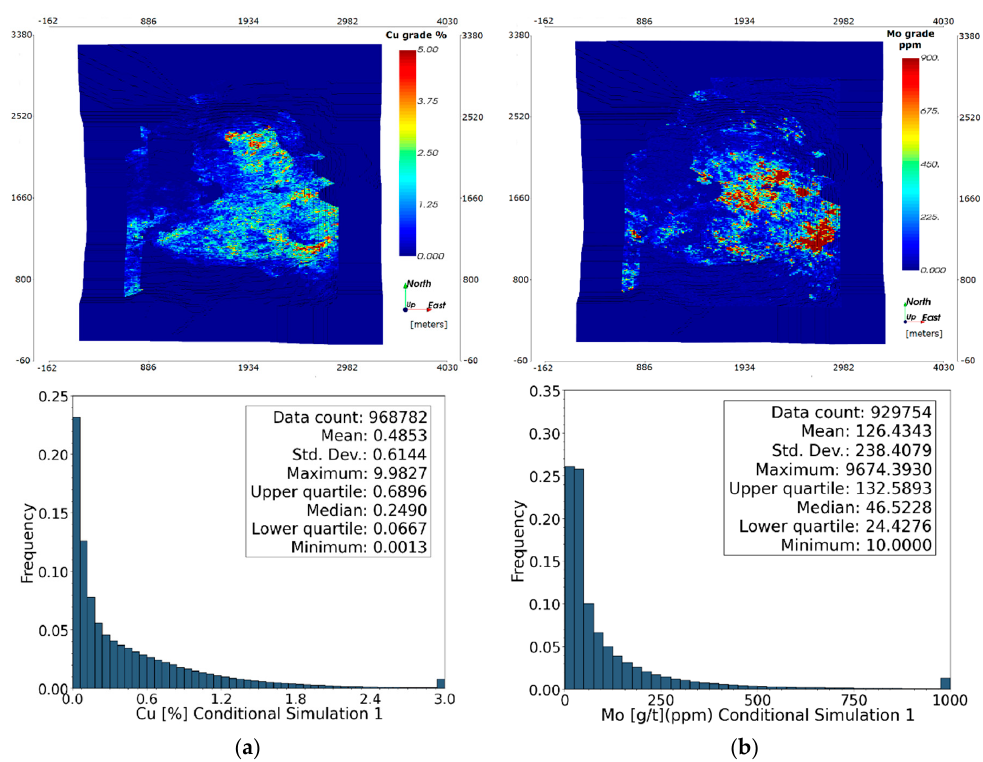
Figure 7. Plan view of geometallurgical models (top) with the associated histogram (bottom) for realization #1. Variables: ( a ) Cu grade (%) and ( b ) Mo grade (gr/ton). Minerals 2019 , 9 , x FOR PEER REVIEW